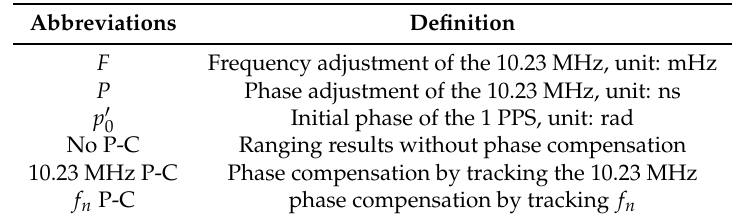
Table 1. Expansion of the abbreviation in Figures 8 and 9.